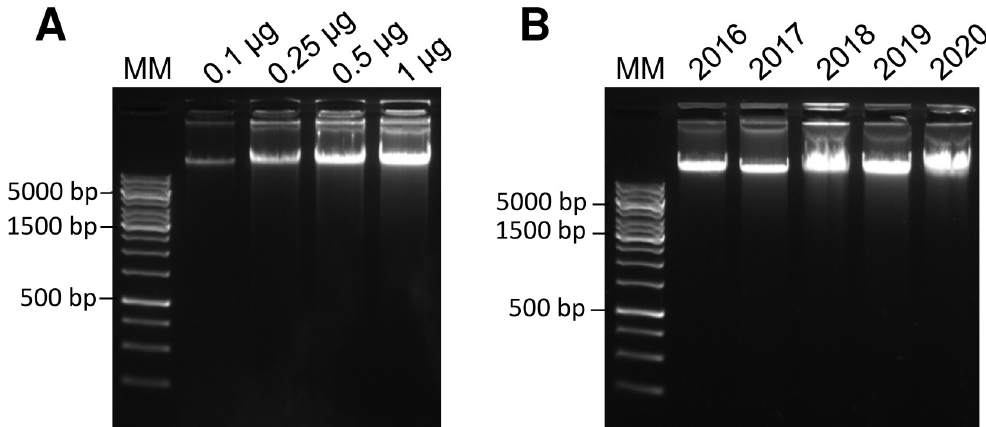
Fig 1. DNA integrity according time of storage in the biobank. After extraction, DNA was separated on 0.8% agarose gel and visualized by Gel Red staining on an imager. (A) Electrophoresis of increasing amounts of DNA after extraction from PAXgene tube. (B) Electrophoresis of DNA after extraction and storage at –80˚C. The year in which the extraction is carried out is indicated. MM: molecular markers. https://doi.org/10.1371/journal.pone.0278780.g001 tissue (VAT), 2.07 for liver and 2.05 for muscle (Table 6; n = 57). Overall, 36 out of the 57 sam- ples had the theoretical expected A260/280 ratio of 2.0 or greater, indicating that 63.2% of RNA samples were relatively free of proteins. In addition, 17/18 SCAT RNA samples, 16/16 VAT samples, 11/12 muscle samples, and 6/11 liver samples displayed a satisfactory RIN � 7 (50/57 samples) (Tables 2 and 6). As previously described [11], RIN from liver were signifi- cantly lower than other tissues (P < 0.01 versus SCAT; P < 0.001 versus VAT; P < 0.01 versus muscle), with four samples having a RIN between 6.7 and 6.9, and only one below 6.7. Repre- sentative electrophoregrams obtained for the four different tissues were shown in Fig 2. In contrast, only one RNA sample out of the 57 tested reached the target 28S/18S rRNA ratio of 1.9–2.1 (Table 6), as we previously observed [11].